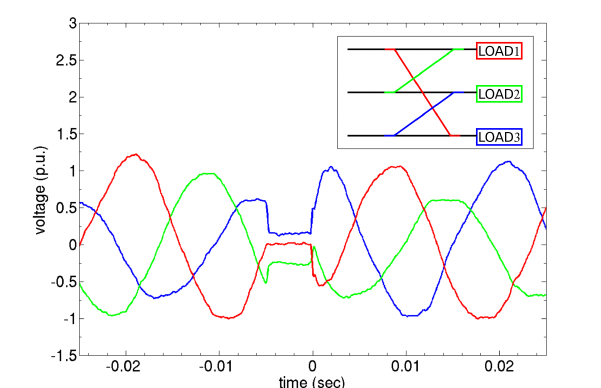
Figure 9. Experimental power routing for unbalanced sources. Power router can successfully make the switching but there is a characteristic delay between switching caused by this voltage